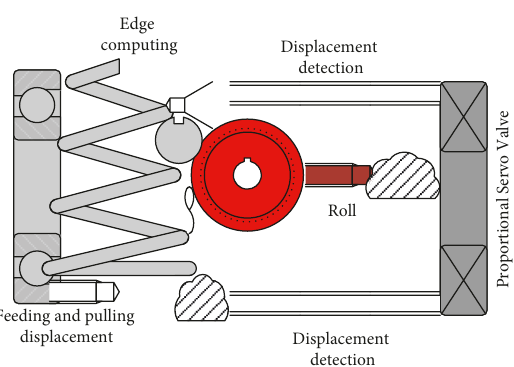
Figure 7: Control block diagram of variable section automotive leaf